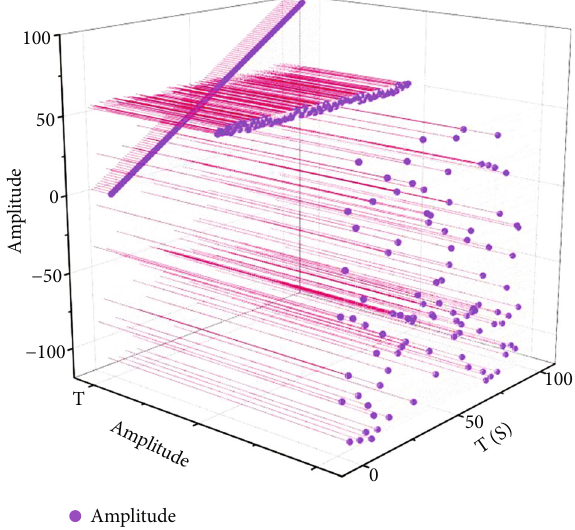
Figure 5: Comparison of results of the model in di ff erent